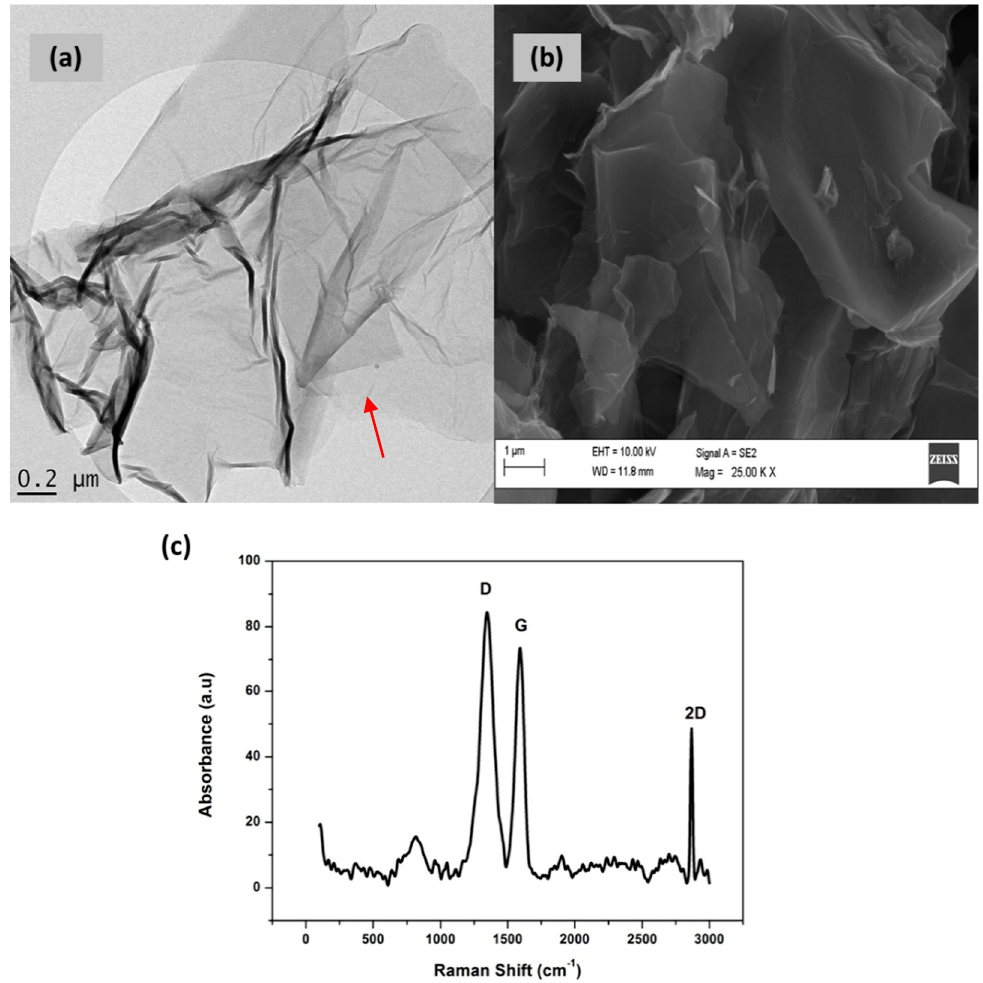
Figure 3. Selected structural and morphological characterization of synthesized graphene: ( a ) high resolution transmission electron microscopy (HRTEM); ( b ) high resolution scanning electron microscopy (HRSEM) and ( c ) raman spectroscopy.